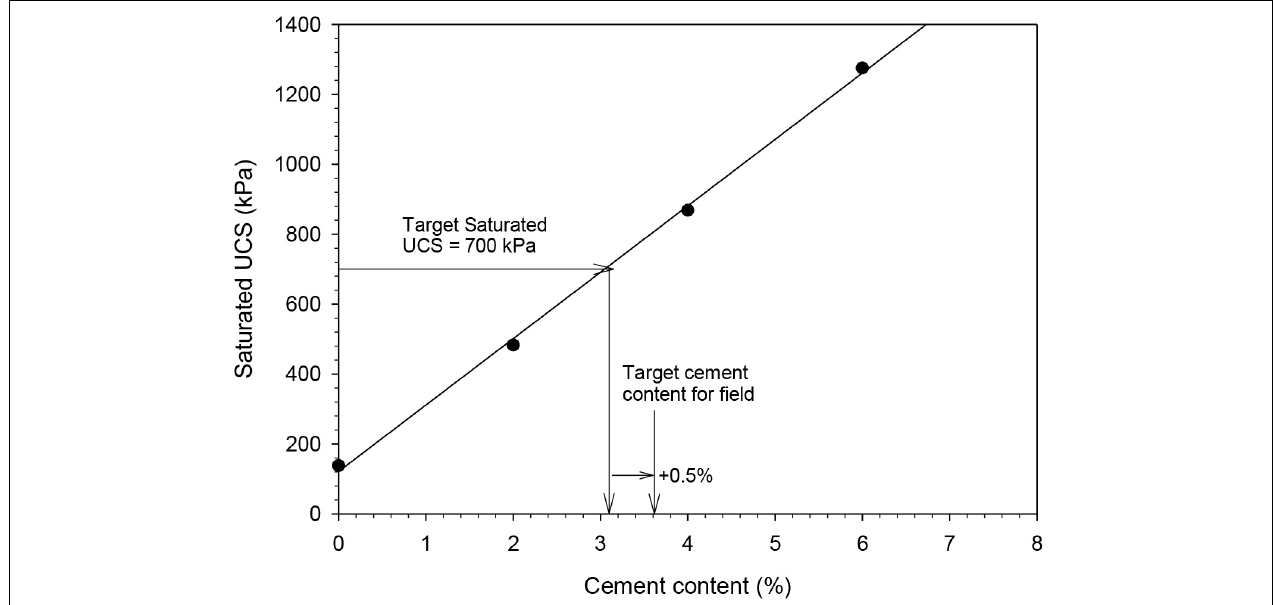
FIGURE 8 | Determination of target cement content for field